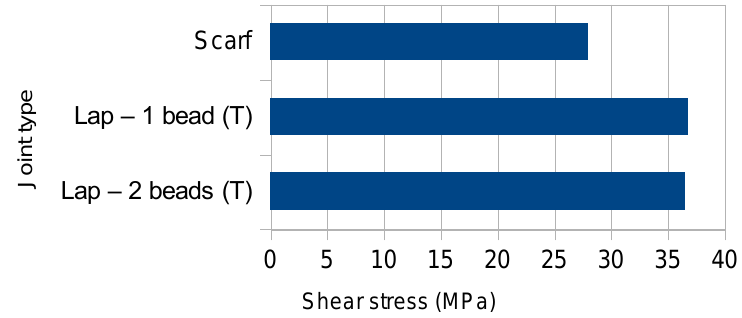
Figure 10. Average failure shear stress τ uw of the joints tested.